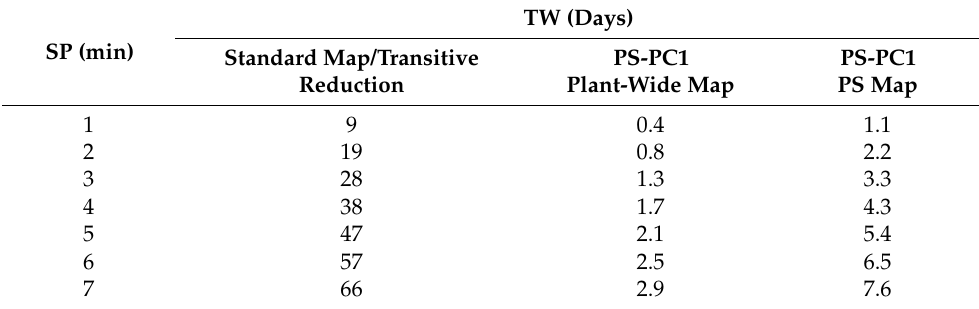
Table 2. Minimum TW of fault-state data required to provide sufficient samples for unique regression solutions. For the standard map/transitive reduction, 13 562 samples are required; for the PS-PC1 plant-wide map, 602 samples are required; for the PS-PC1 PS map, 1562 samples are